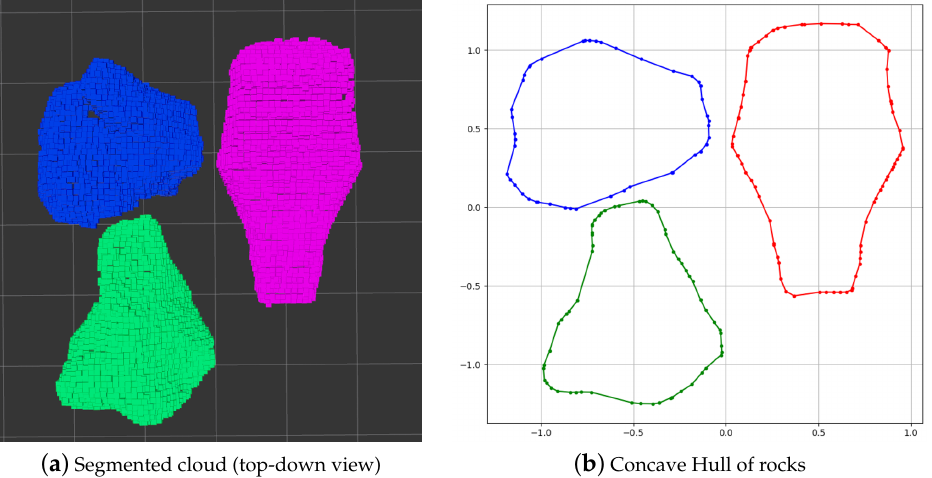
Figure 12. Example of the concave hull algorithm applied to a 2D projection of a segmented cloud. ( a ) Segmented cloud, where each rock instance is represented with a different color. ( b ) Concave envelope area generated by the algorithm.